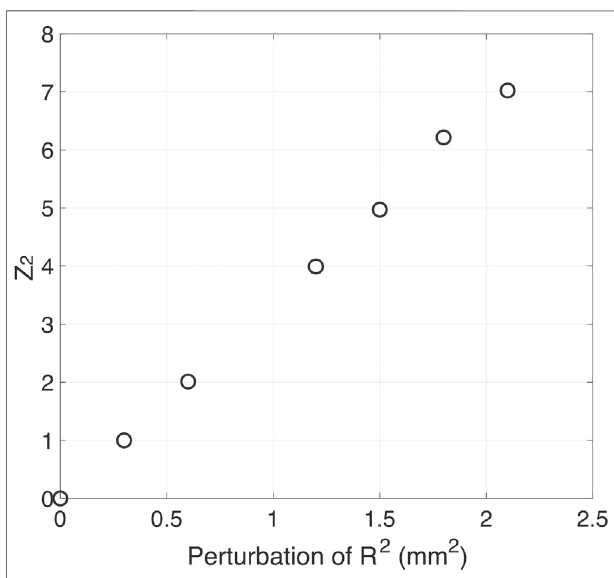
FIGURE 2 | The relation between perturbation of R 2 and Z 2